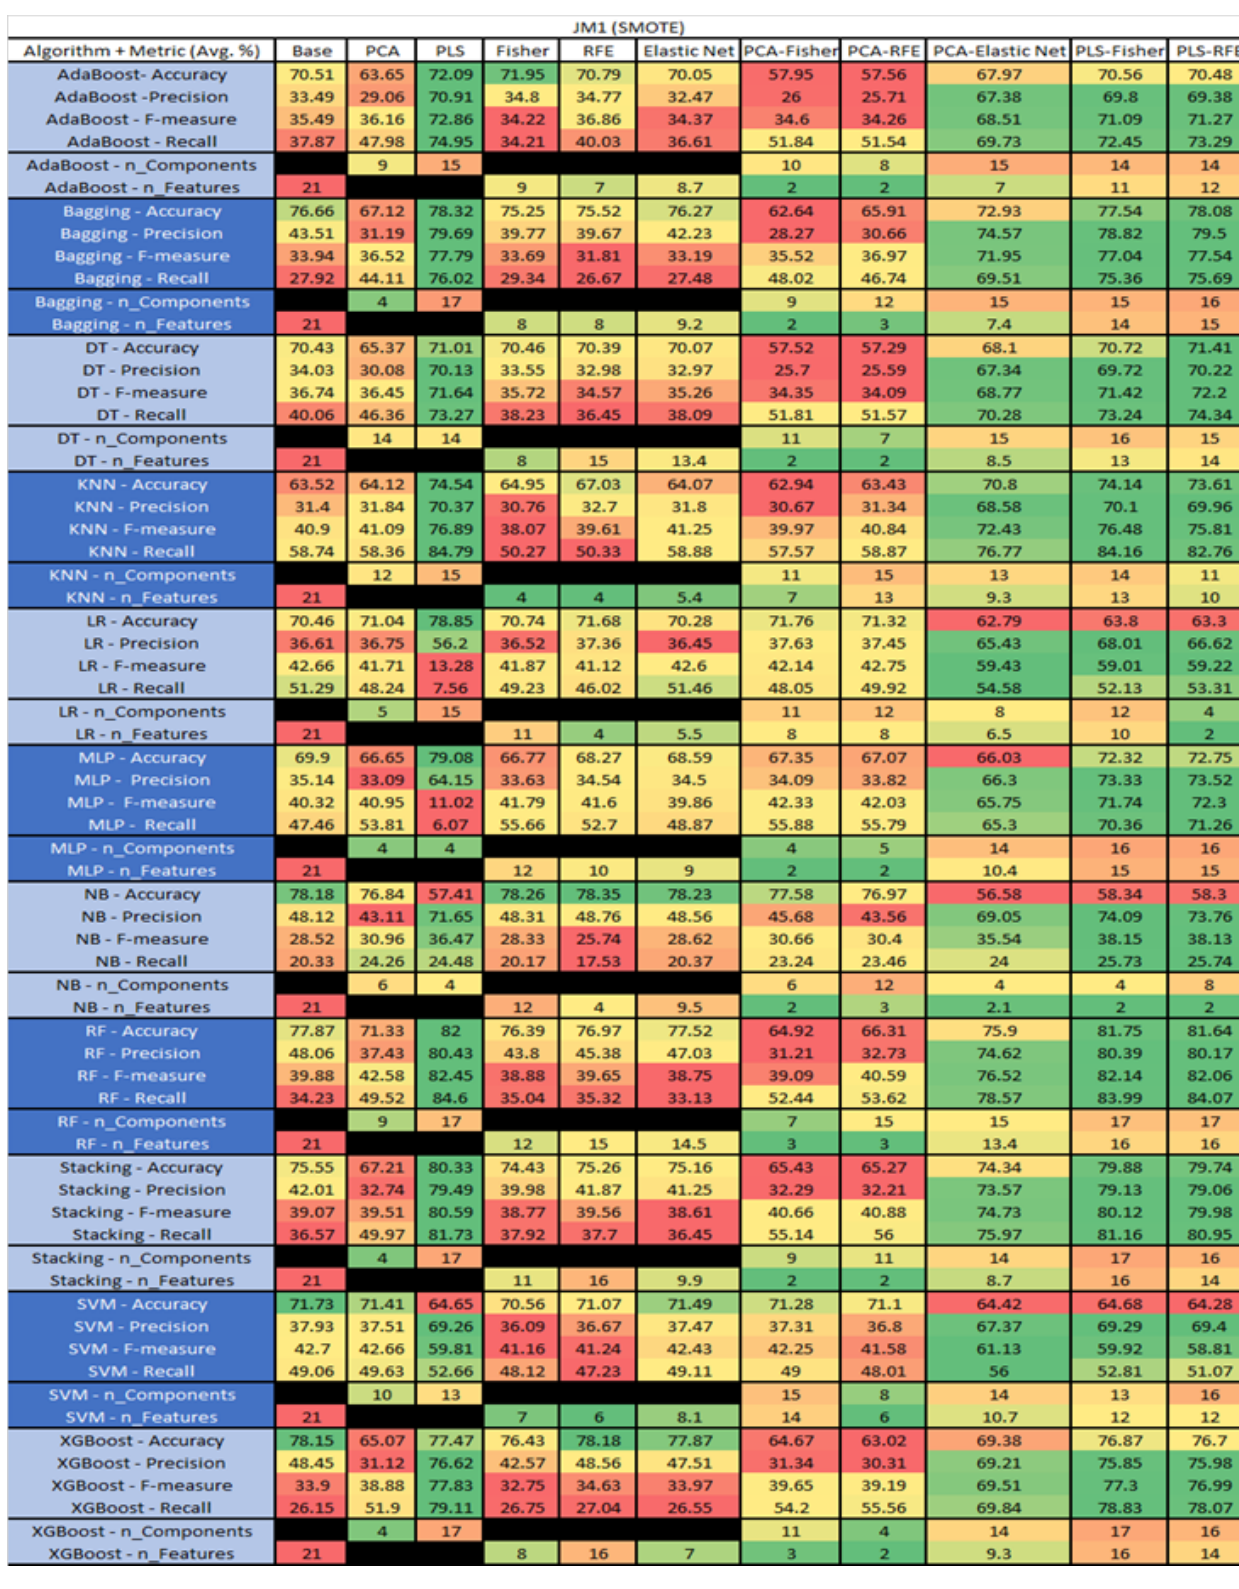
Figure 25. JM1 with SMOTE NASA MDP Results Data